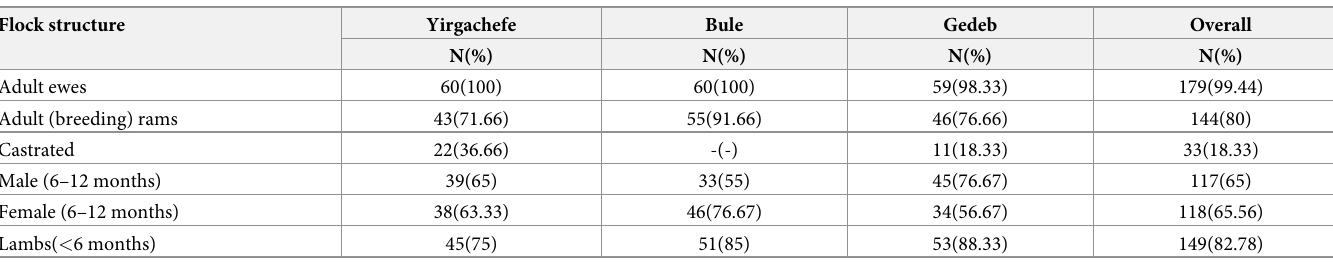
Table 1. Percent possession of sheep by respondents.